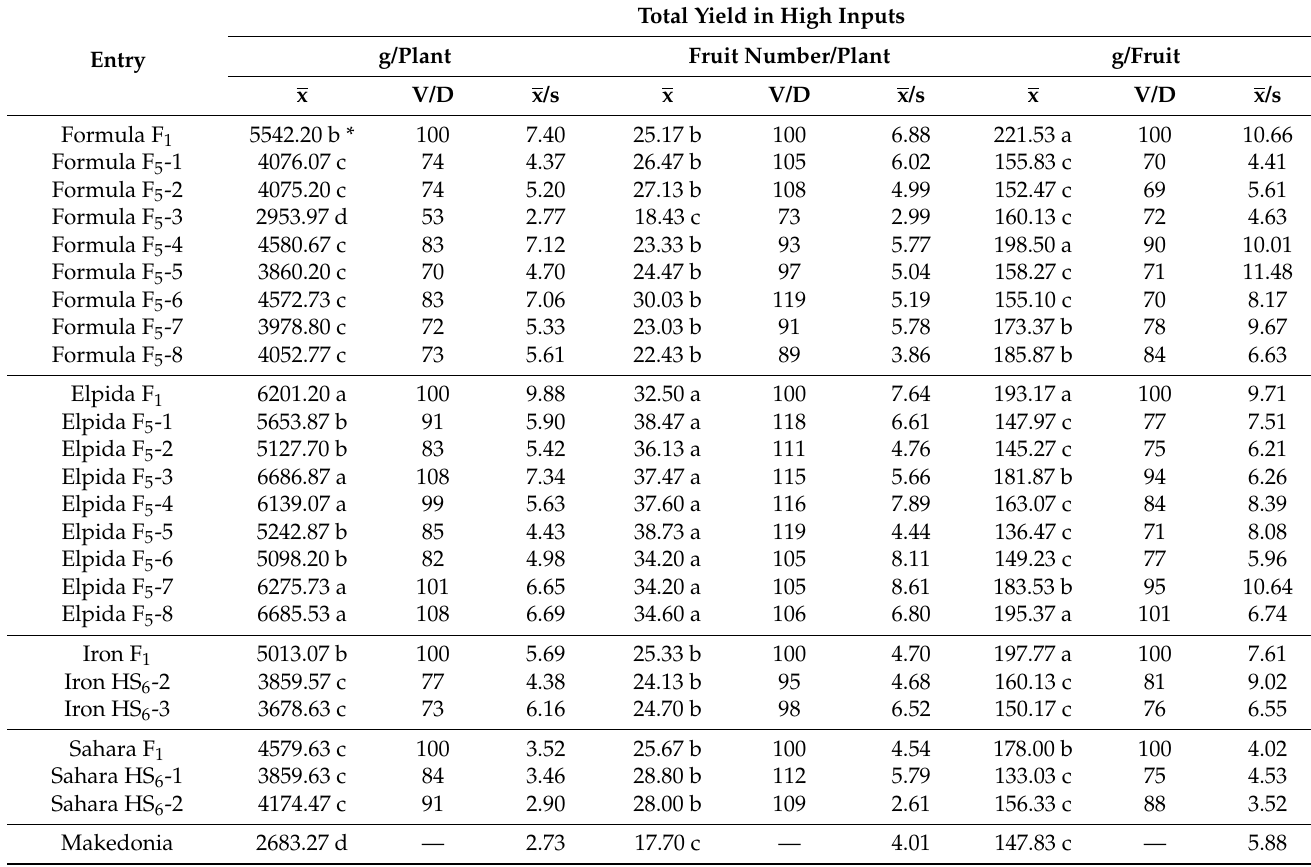
Table 2. Total fruit yield (g/plant, fruit number/plant, and g/fruit), vigor/depression (% of its corresponding hybrid), and stability of performance ( x /s) of the hybrids and new recombinant inbred lines in the high-input farming